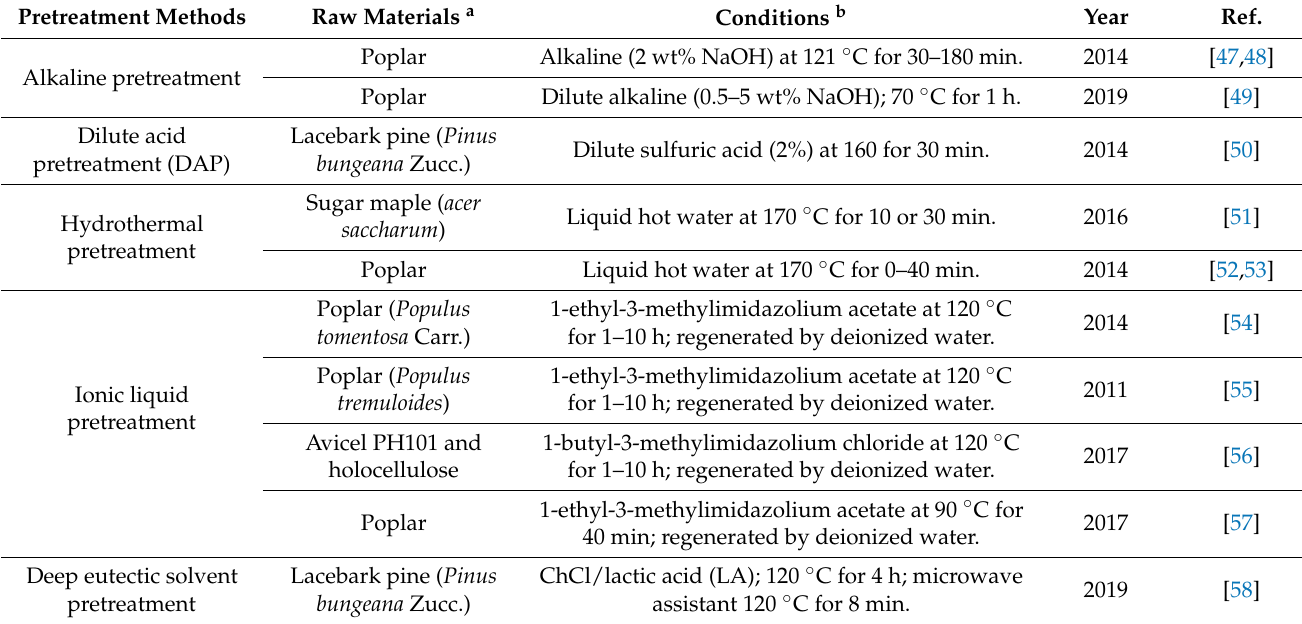
Table 5. Pretreatment methods from references discussing cell wall